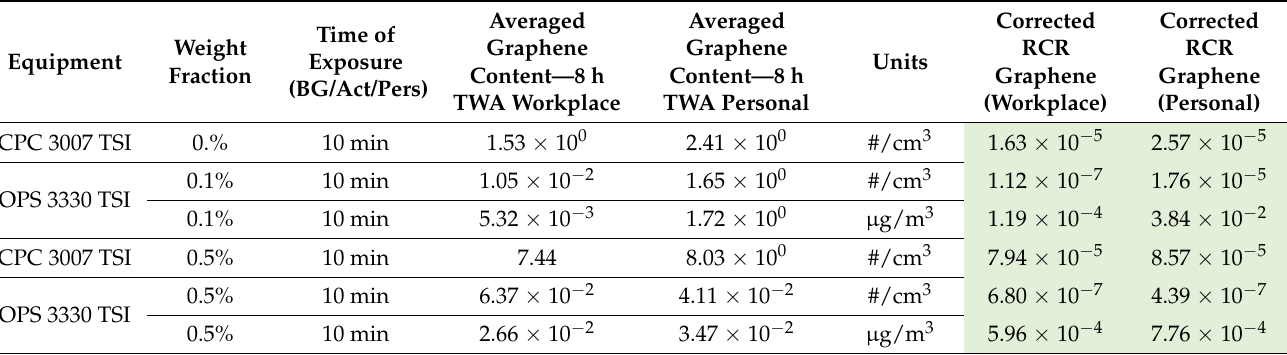
Table 3. Data measured during paint spill containing